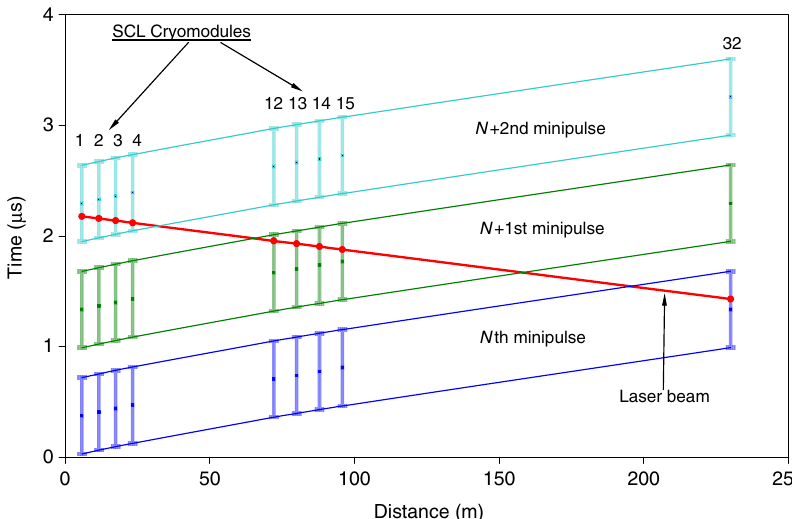
FIG. 4. Temporal-space representation of the laser pulse and ion beam’s minipulses along the SCL. Distance is from the beginning of SCL. Laser pulse and ion pulses are traveling in opposite